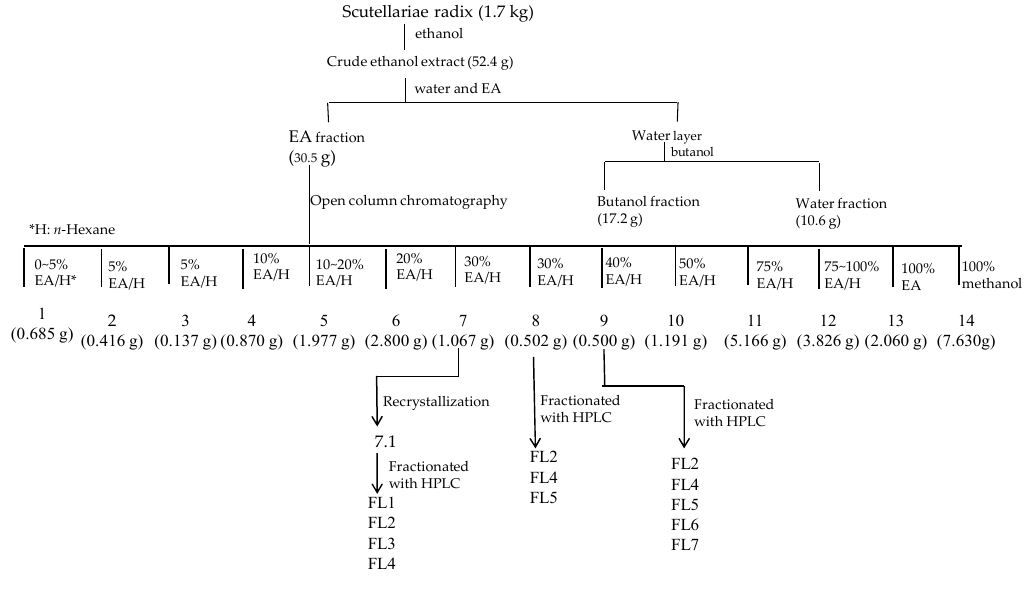
Figure 4. Isolation flowchart of FL1 – 7 .